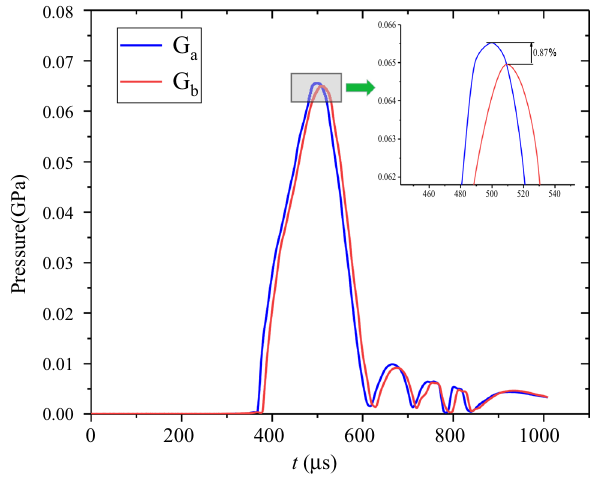
Fig. 8 Pressure change of measuring point at interface